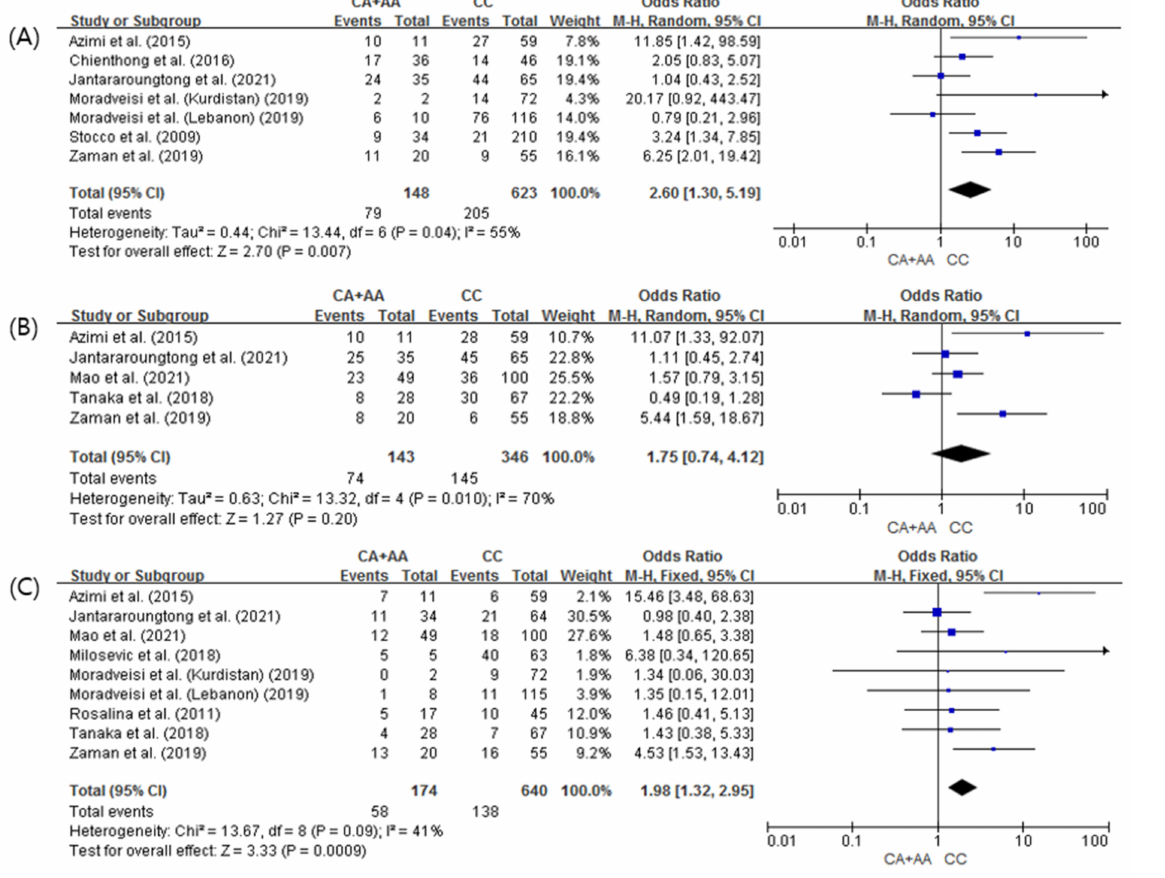
Figure 2. Forest plot of the association between ITPA 94C>A polymorphism and 6-MP-induced toxicities: ( A ) Neutropenia, ( B ) Leukopenia, and ( C )